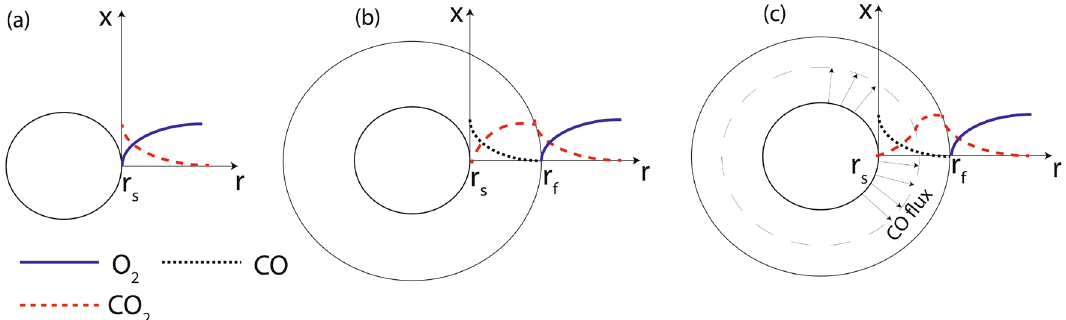
Figure 7. Variation of O 2 , CO 2 and CO mole-fraction in the film ( a ) conventional single-film approach, ( b ) conventional two-film approach ( c ) current approach.